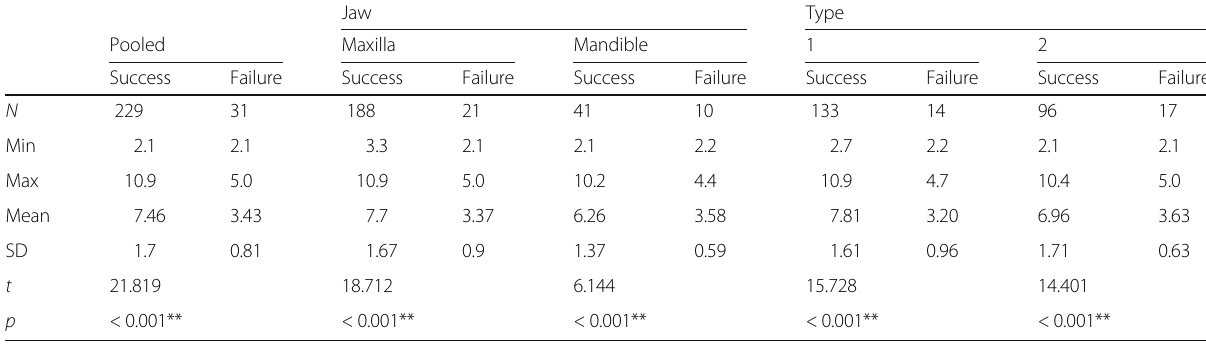
Table 3 Comparison of DC distance (mm) between the two groups in the pooled sample, in each jaw separately and by mini- implant type